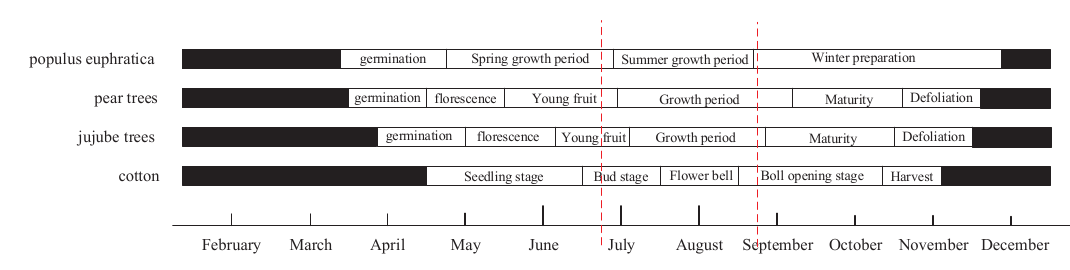
Figure 2. Main phenological information of study